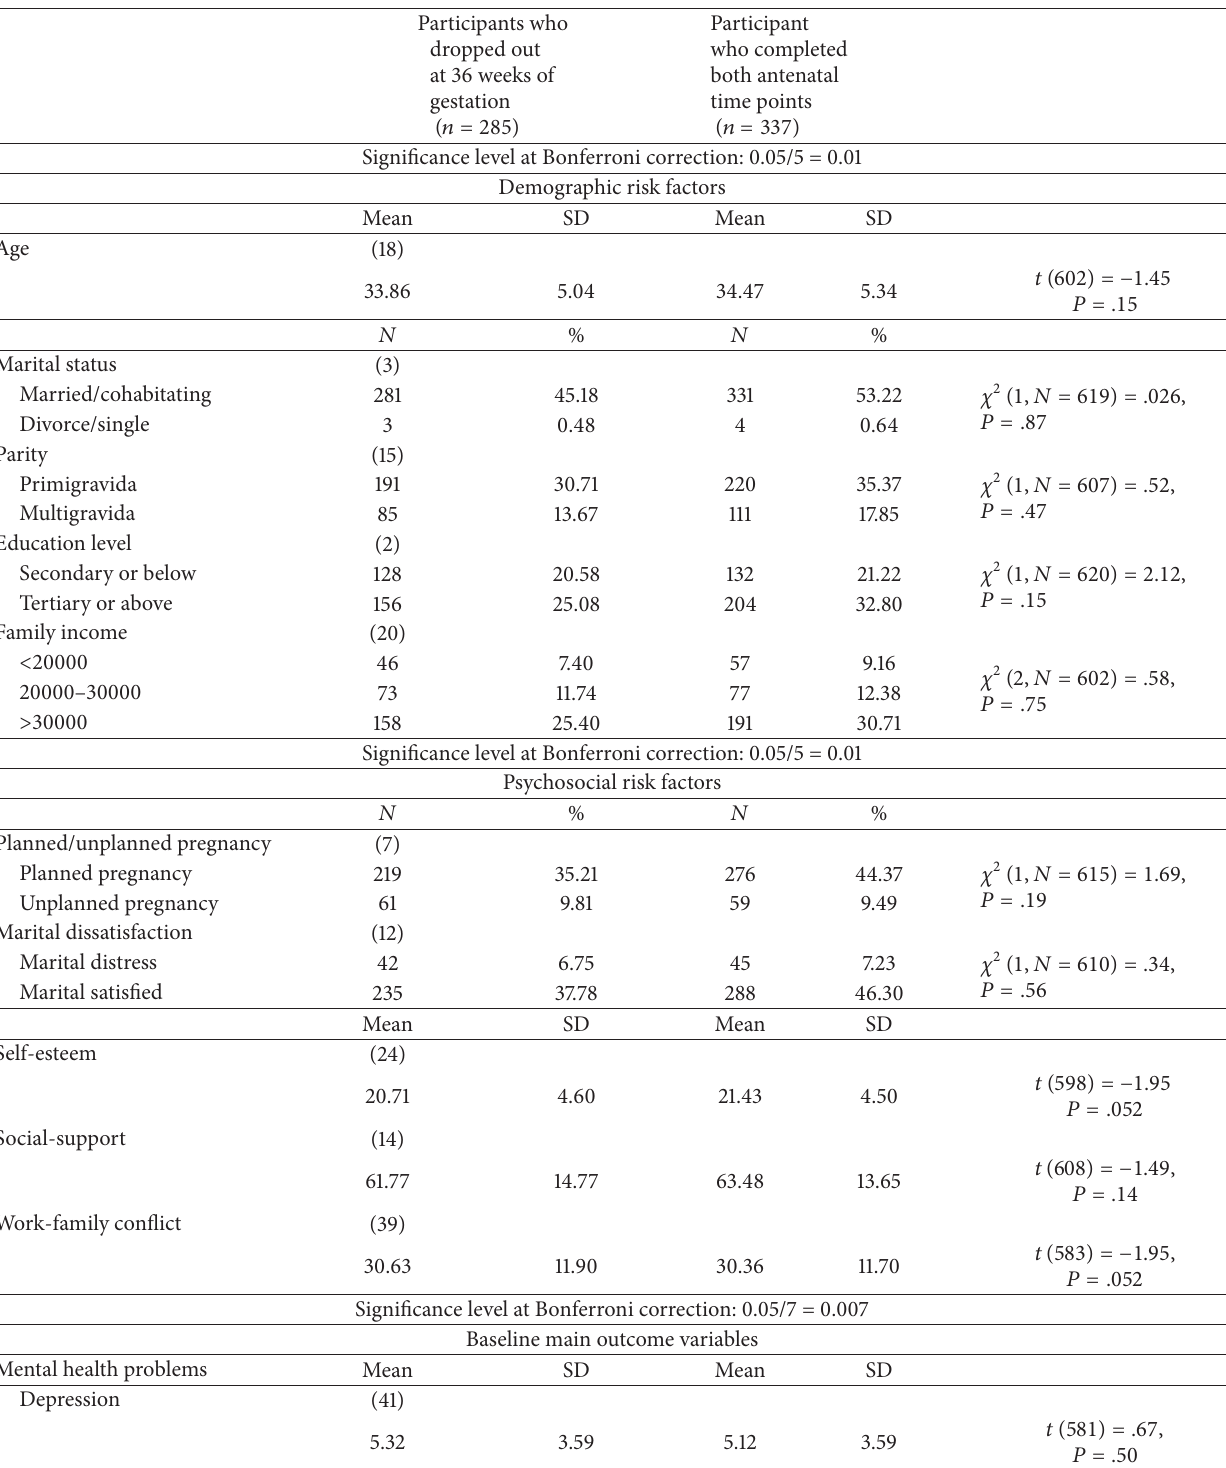
Table 1: Sample characteristics and attrition analysis of expectant fathers with comparison between fathers who completed both antenatal time points and fathers who dropped out in late